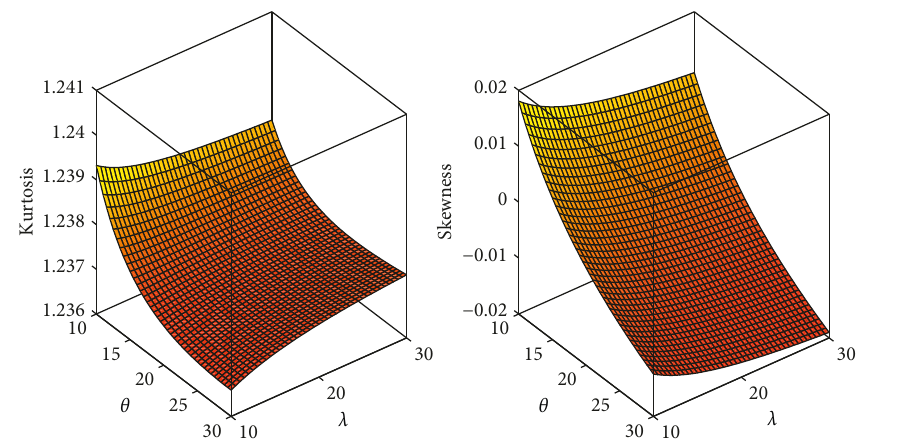
Figure 2: Kurtosis and skewness